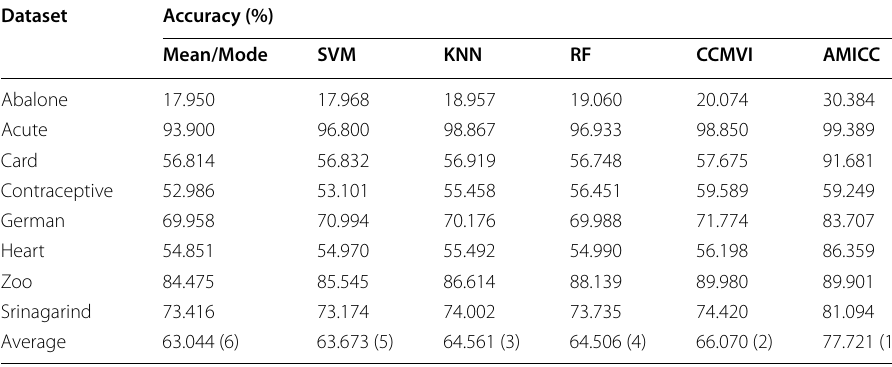
Table 9 Average classification accuracies of the MVI methods for the mixed datasets